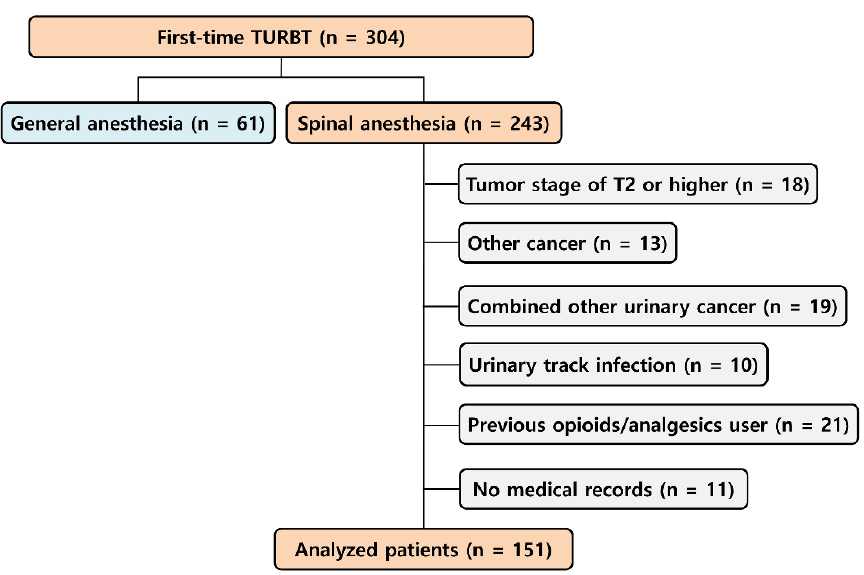
Figure 1. Flowchart of study patients. In January 2000–December 2007, 304 patients who underwent first-time elective TURBT at our institution were assessed. Finally, 151 patients were subjected to the study protocol. TURBT, transurethral resection of bladder tumor.